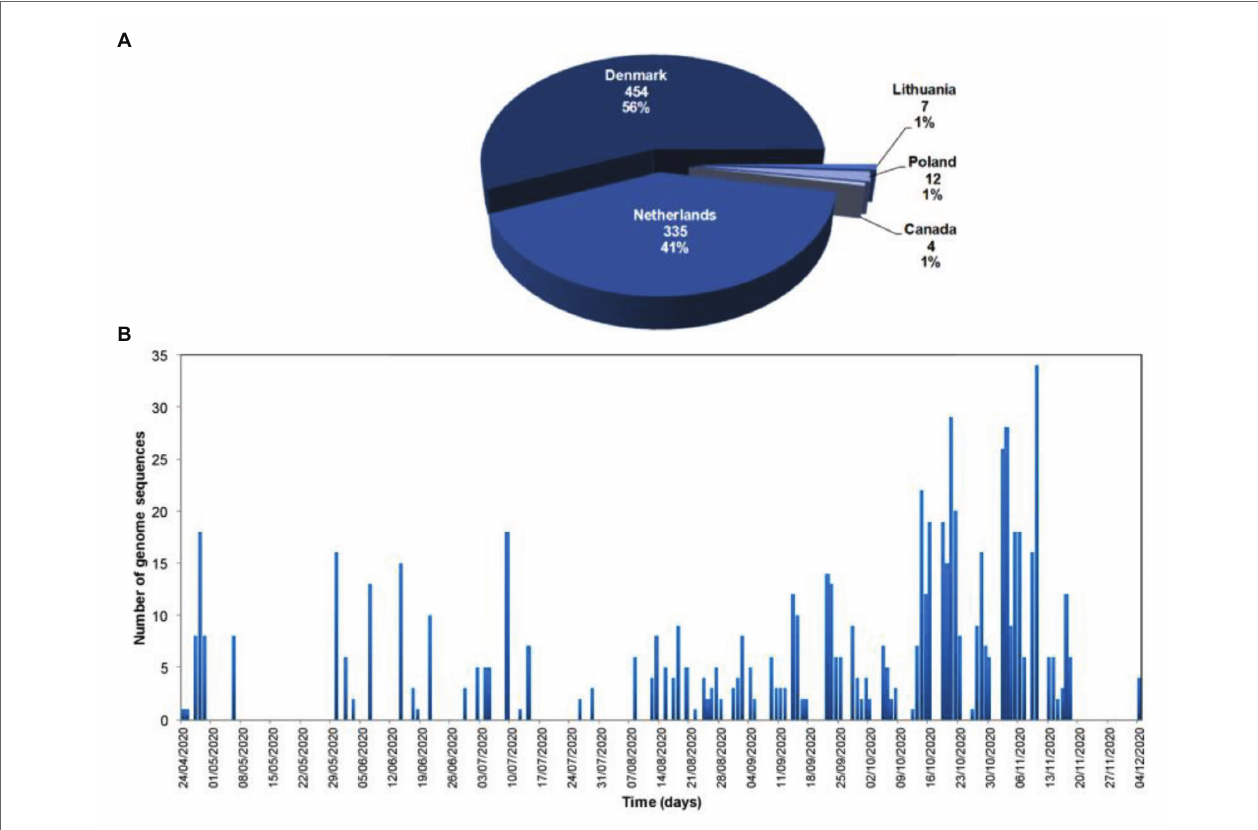
FIGURE 3 | Number and geographic origin of mink SARS-CoV-2 genomes available in the Global Initiative on Sharing Avian Influenza Data (GISAID database; https://www.gisaid.org/; Accessed February 02, 2021). (A) Pie chart of the number of SARS-CoV-2 genome sequences from minks per country, and proportion of the total number of SARS-CoV-2 genome sequences from minks; (B) Temporal distribution of the number of SARS-CoV-2 genome sequences from minks per day of sample